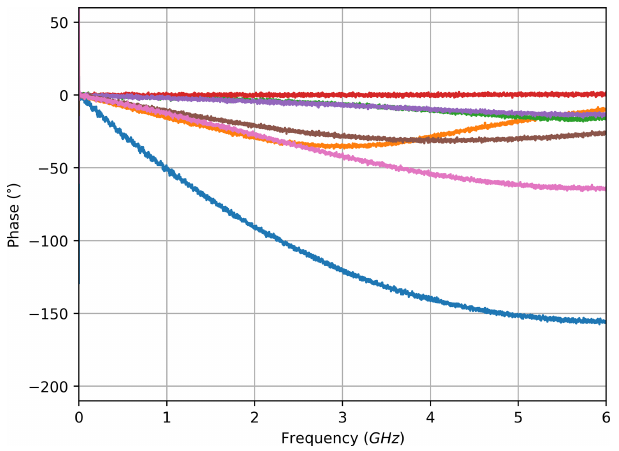
Figure 8. Electrical phase of S21 measurements of an FBG in trans- mission configuration.